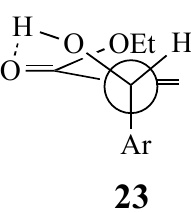
N F Scheme 2. Control experiment: Selective reaction of the MBH acetate and formation of the Z alkene 22 (CCDC 2035022). Analysis of the reactant in the S N 2 ′ reaction (Option 2 above) demands that the starting conformation minimizes the steric interaction between the aryl, the acetoxy, and the electron ‐ withdrawing group (EWG = CO 2 Et or CN) (Scheme 2). An earlier study describing the reaction of an acrylate ‐ derived MBH alcohol with HBr proposed conformation 23 (Figure 2), which has an additional stabilizing H ‐ bond between the OH and the EWG, to rationalize the products [20]. This model would favor formation of the alkene that places the incoming active methylene fragment cis to the 2 ‐ fluoro ‐ 5 ‐ nitrophenyl moiety in the product. With the current substrates, H ‐ bonding is not possible, and so the large acetoxy group was expected to orient away from the EWG (perhaps more so for CO 2 Et than CN) to minimize steric crowding (Scheme 3). Then, an initial S N 2 ′ reaction involving a syn orientation of the nucleophile and leaving group invoked in some earlier work